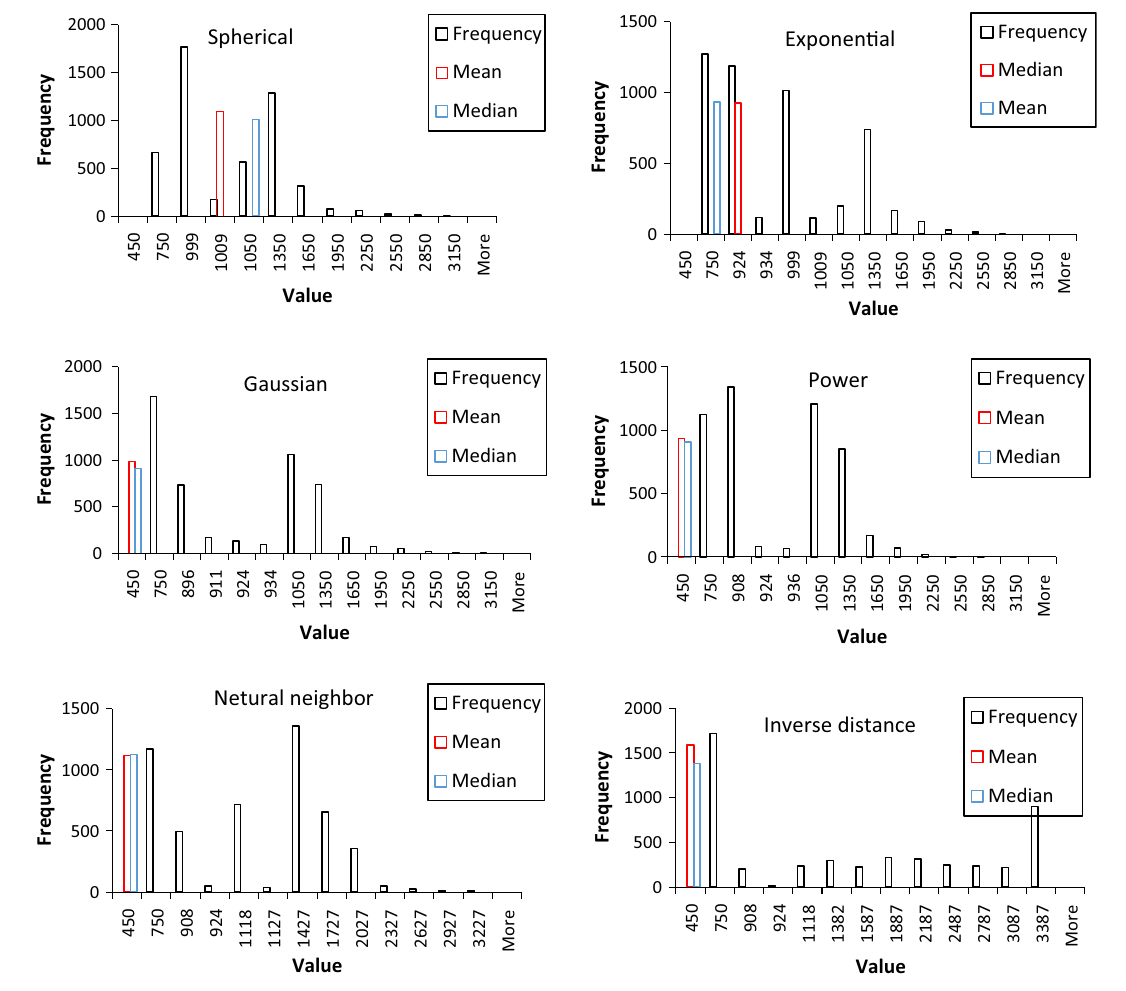
Fig. 8 Histogram of TDS concentration of 3500 cells for different variogram (obs. 2). The red block illustrate the mean value and the green block illustrate the median